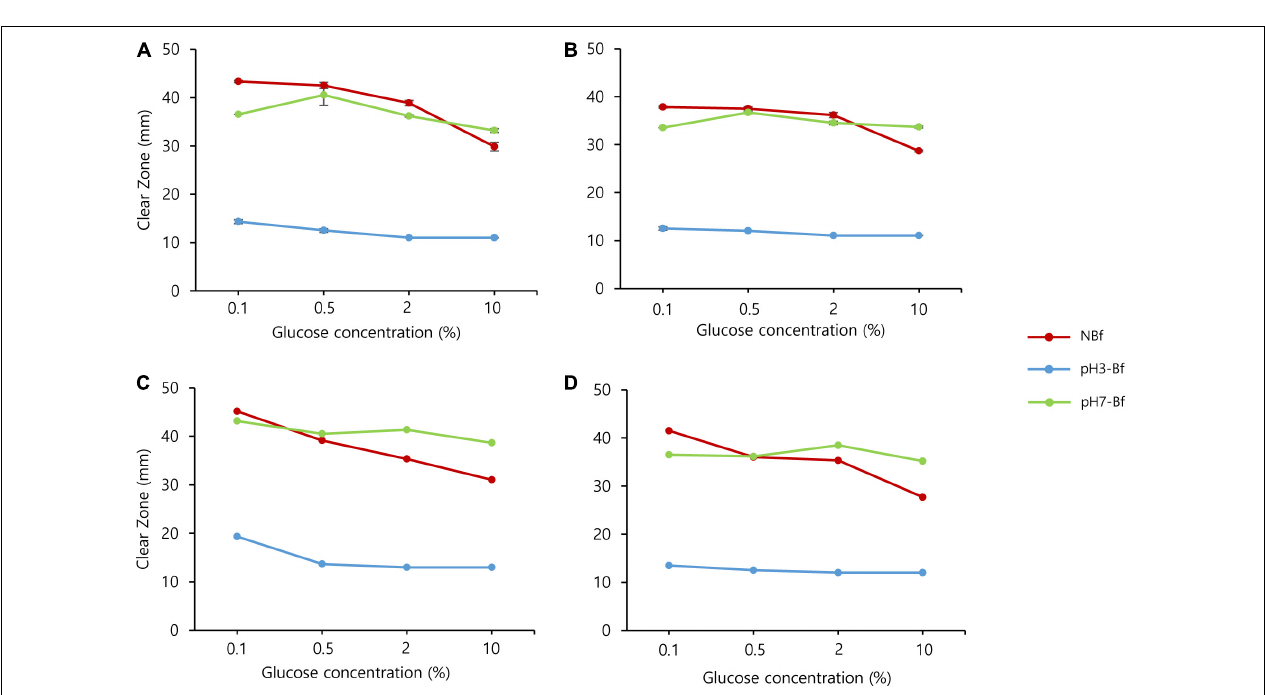
FIGURE 4 | Saccharomycopsis fibuligera shows reduced starch and cellulose degradation as pH decreases. Starch (A,C) and cellulose degradation (B,D) by Saccharomycopsis fibuligera. KPH12 (A,B) strain and KJJ81 interspecies hybrid strain (C,D) were grown on YPG agar plates supplemented with 0.1, 0.5, 2, and 10% glucose in non-buffered (NBf), pH 3-buffered (pH 3-Bf), and pH 7-buffered (pH 7-Bf) conditions. Red, non-buffered; blue, pH 3-buffered; and green, pH 7-buffered.